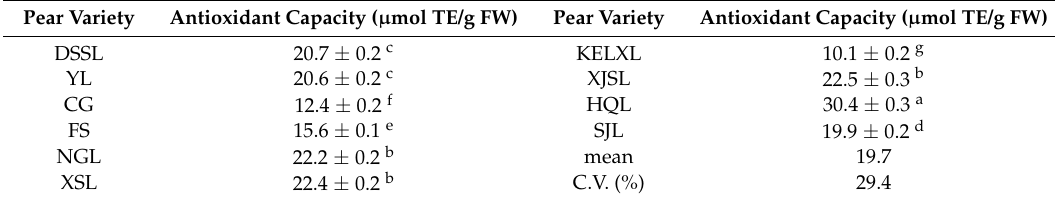
Table 4. Antioxidant capacities of thinned young pears based on DPPH analysis (mean ± SD, n = 3). Pear